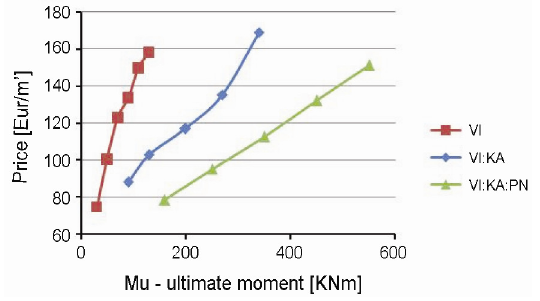
Fig. 13. The relationship between loading capacity limit and